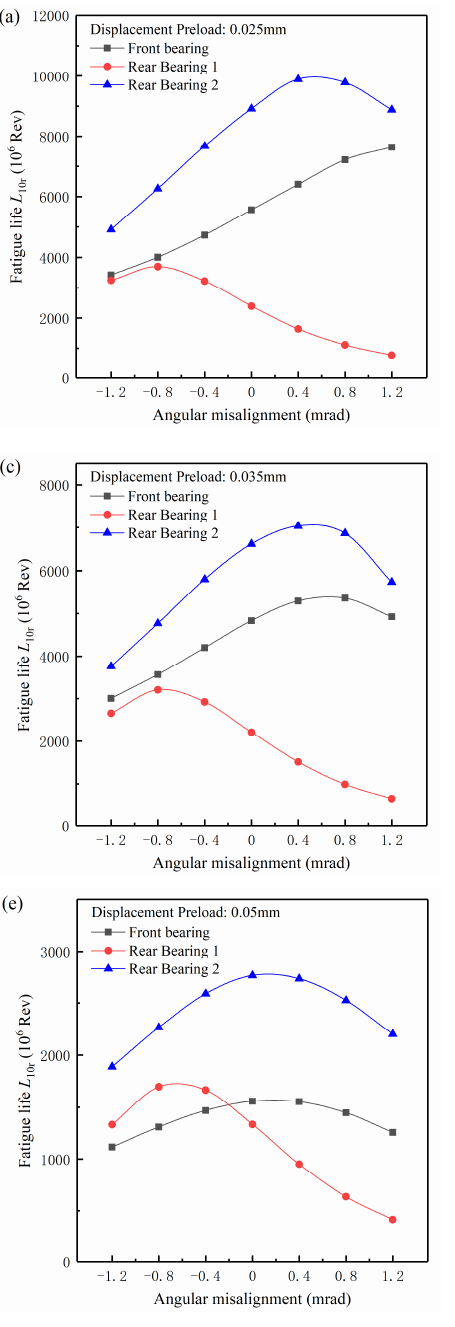
Figure 11. The variation of bearing life with the angular misalignment in the Case I condition (( a ), ( c ) and ( e )) and the Case II condition (( b ), ( d ) and ( f )) for constant-displacement preload.